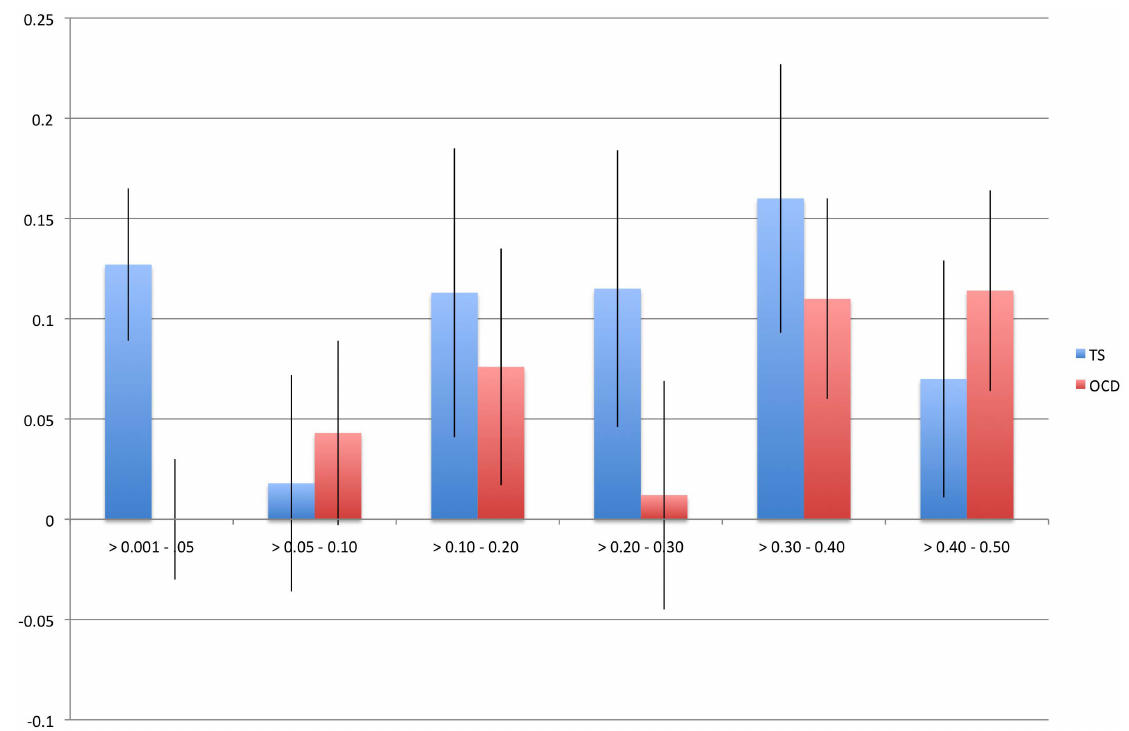
Figure 3. Heritability by minor allele frequency. The x-axis represents all minor allele frequency bins tested while the y-axis represents resultant heritability in a given bin. Blue bars indicate TS and red bars indicate OCD. Error bars are shown.